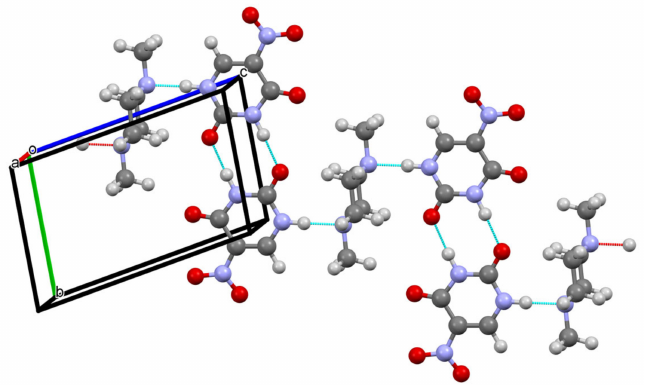
Figure 13. Hydrogen bonded chains in (XII) with different colors portraying different residues.